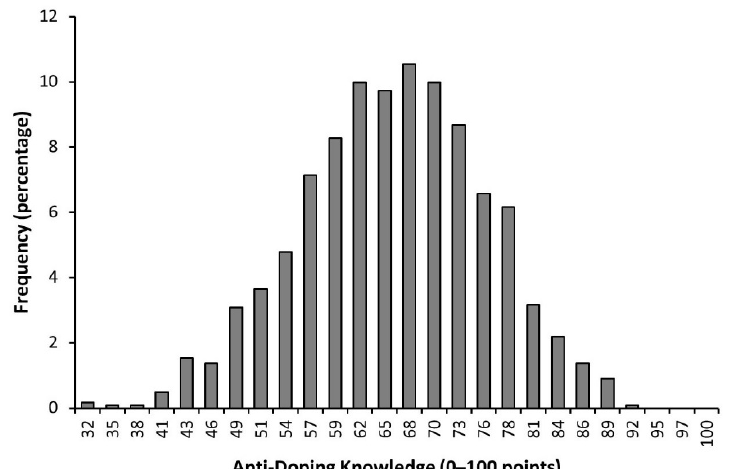
Figure 1. Frequency of bachelor students undertaking a degree in sports sciences in Spanish universities according to their anti-doping knowledge measured by an adapted version of the WADA Play True Quiz. Each bar represents the percentage of students, from a total of 1233, who obtained a given score in the questionnaire.